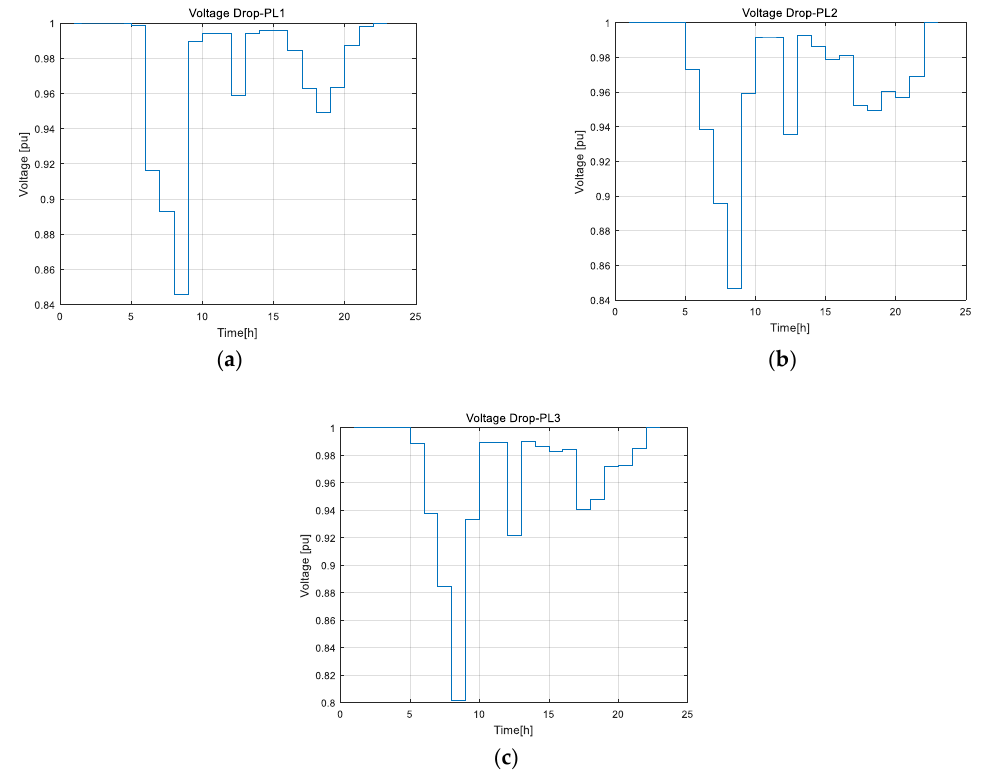
Figure 12. Voltage Variation in each Parking Lot ( a ) PL1, ( b ) PL2, ( c ) PL3.